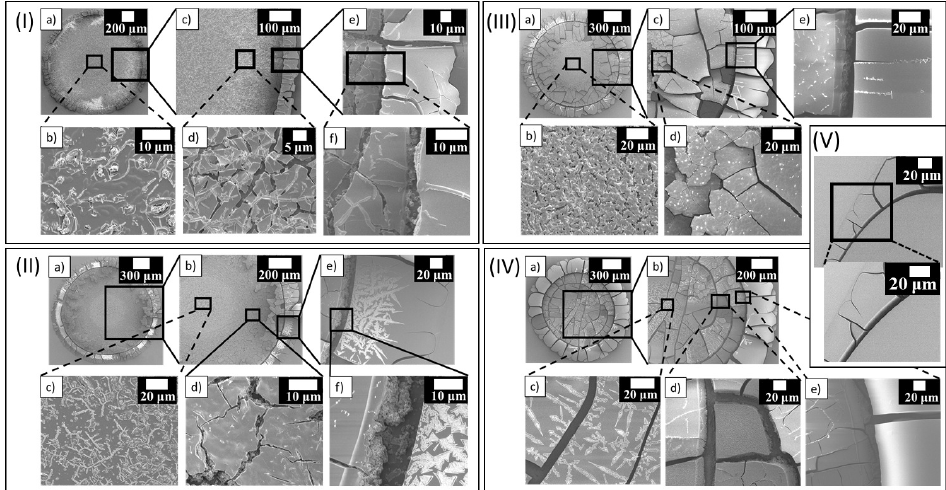
Figure 4. Microscopic images of the dried lysozyme samples are displayed in this figure. ( φ Lys , φ PBS ) = (1.0 wt%, 0.5 × ) in ( I ), ( φ Lys , φ PBS ) = (3.3 wt%, 0.5 × ) in ( II ), ( φ Lys , φ PBS ) = (4.8 wt%, 0.5 × ) in ( III ), ( φ Lys , φ PBS ) = (9.0 wt%, 0.5 × ) in ( IV ), and ( φ Lys , φ PBS ) = (9.0 wt%, 0 × ) in ( V ). Different length scales are shown as the scale bars in the upper-right corner of each